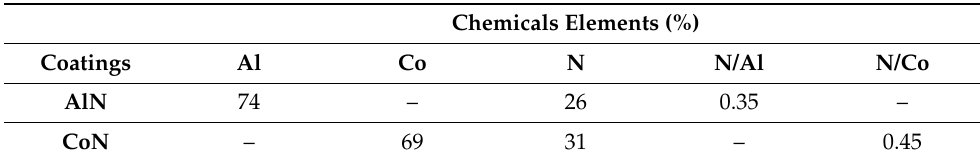
Table 2. Chemical composition and stoichiometric relation for all AlN and CoN coatings from XPS results.